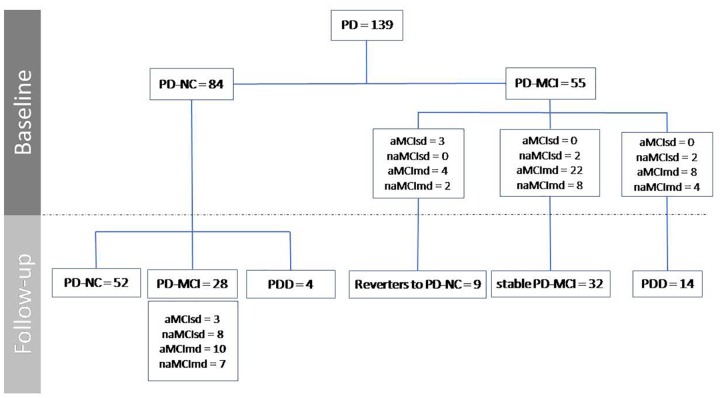
Progression of PD-NC and PD-MCI from baseline to follow-up.